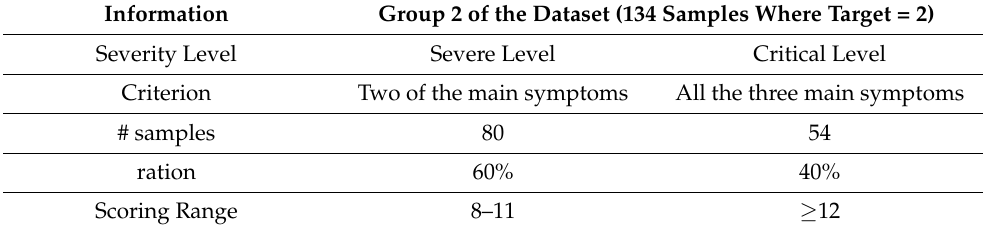
Table 13. Statistical results for Group